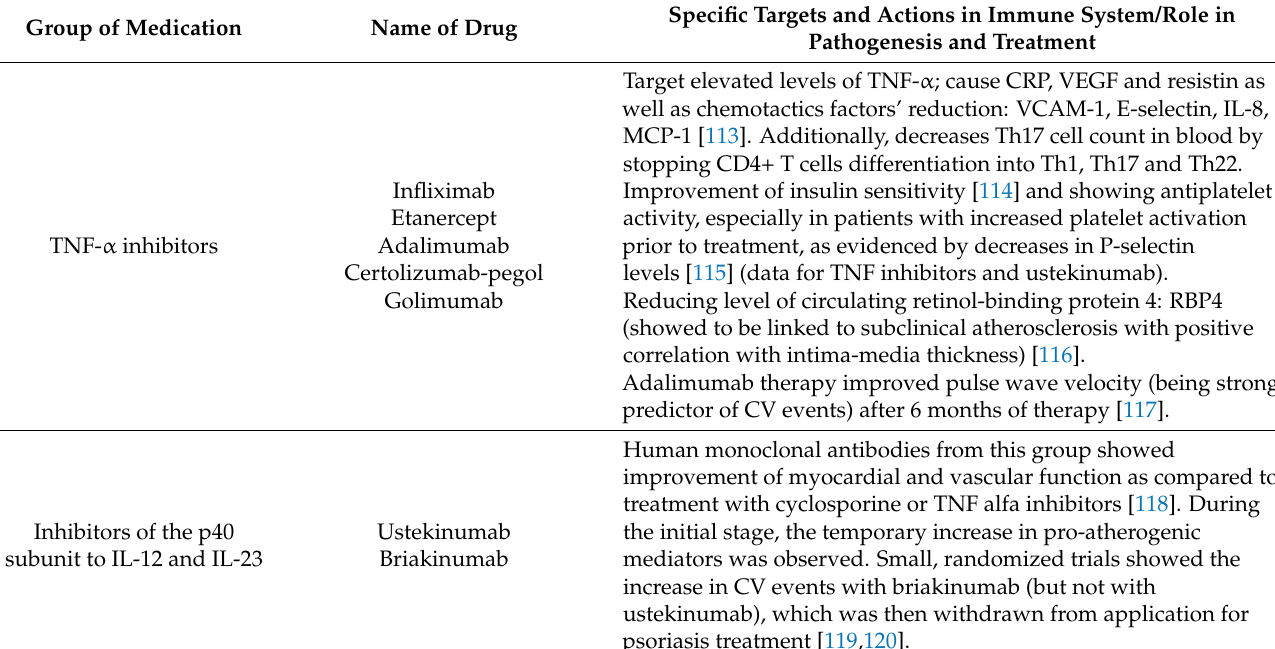
Table 2. Biologic medications used in PSO/PSA treatment with their respective target of action and the connection with